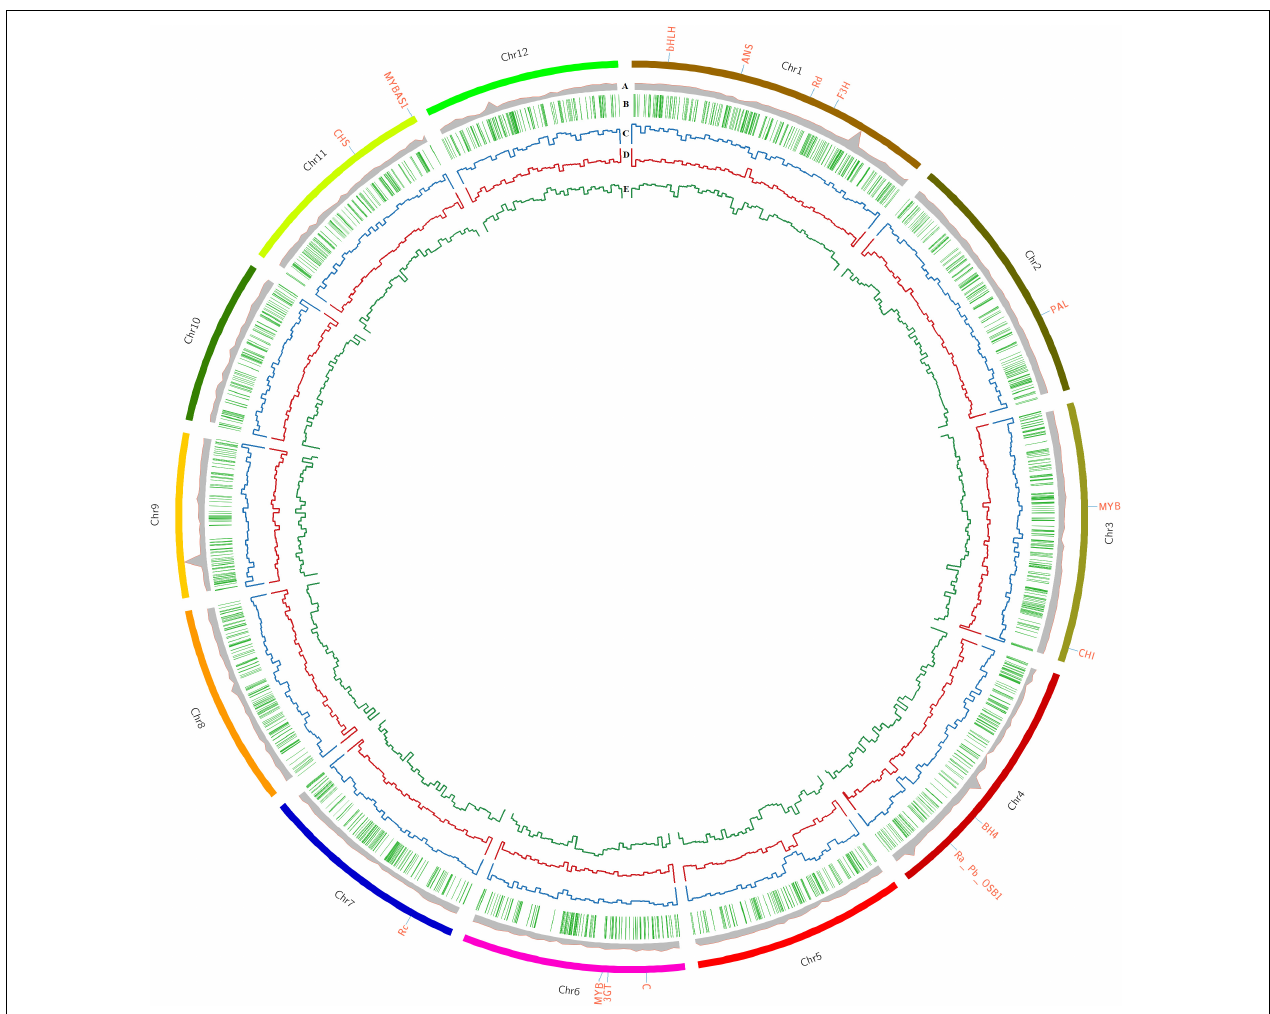
FIGURE 1 | Comprehensive genome-wide analysis of Purpleputtu (PP) characteristics with Nipponbare reference genome. Circle diagram represents (A) read depth, (B) gene density, (C) insertion density, (D) deletion density, (E) SNP density. Outer circle of diagram represents the chromosomes of PP genome, each one labeled with important genes.